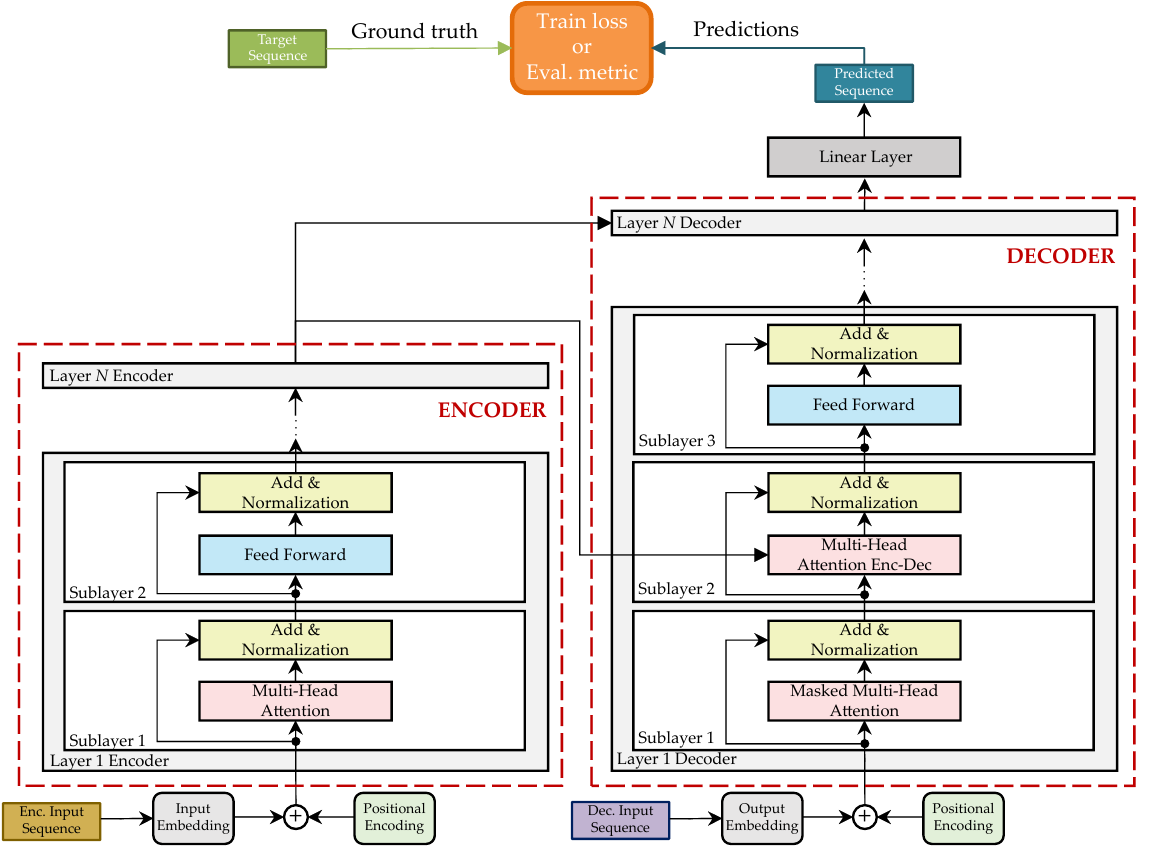
Figure 11. Model architecture of the TNN based on